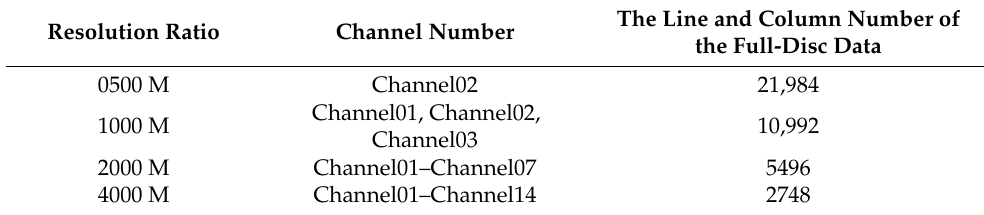
Table 5. The channel number and the number of line and